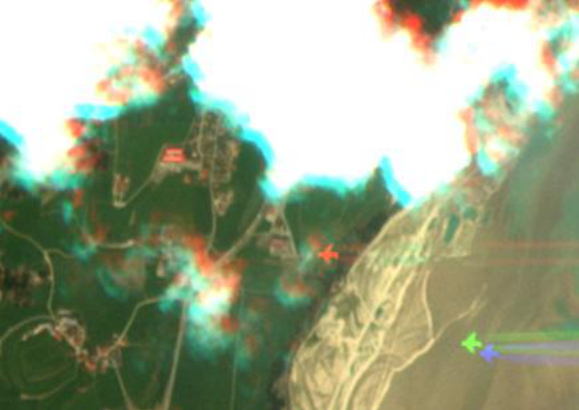
Figure 2: Section 2 . 1 × 1 . 5 km from a RapidEye scene of southern bavaria (north of F¨ussen) containing clouds and a plane investigated are WorldView-2, RapidEye, Pl´eiades and also the new SkyBox satellites. These sensors are like most of all very high resolution earth ob- servation sensors built up as pushbroom scanners or a special pushbroom-frame-camera configuration in the case of SkyBox. To acquire different spectral bands for each band one CCD line is necessary. Most sensors have the panchromatic CCD line and the multispectral CCD scan lines mounted separately on the fo- cal plane assembly with a distance of several millimeters. Oth- tispectral CCD scan lines mounted separately. In the case